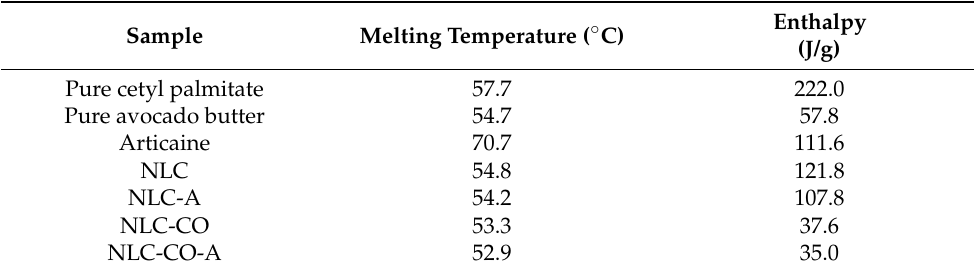
Table 3. Melting temperature and enthalpy determined from the DSC thermograms (Figure 1) of the NLCs and their